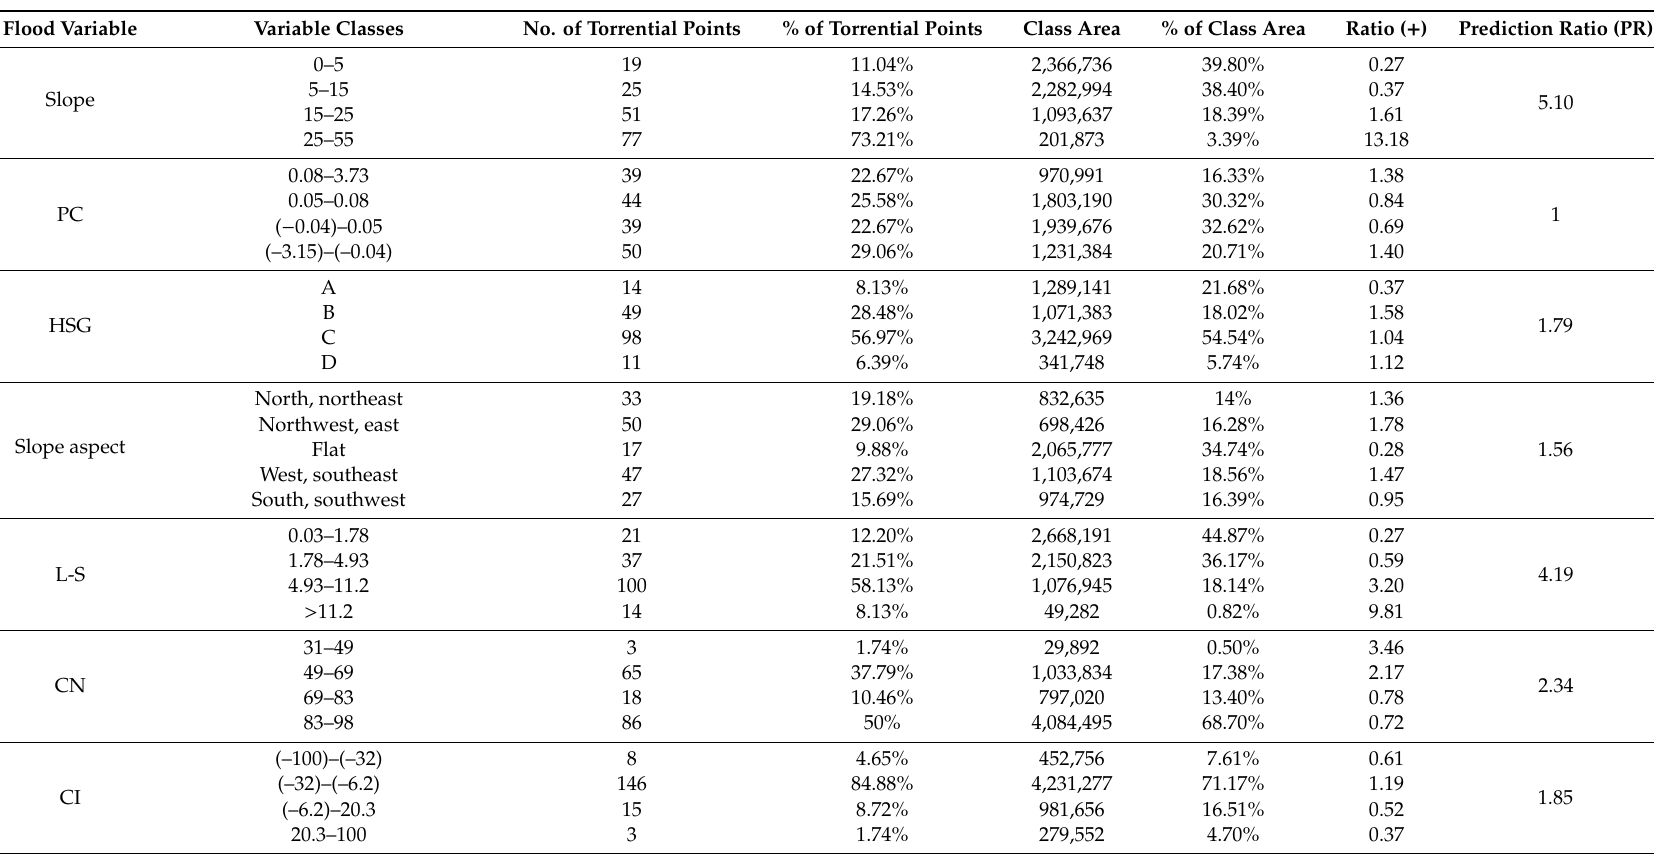
Table 3. Frequency and prediction ratio and the distribution of the flood locations and classes of each flash-flood conditioning variable. PC: plan curvature; CN: curve number; CI: Convergence Index; SEW: soil erodibility by